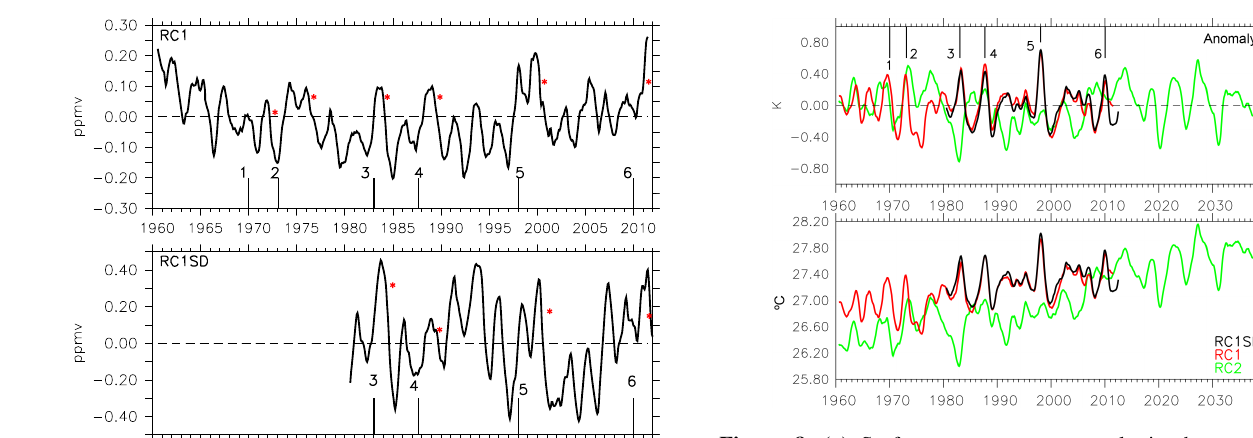
Figure 8. (a) Surface temperature anomaly in the tropical re- gion (10 ◦ S–10 ◦ N) (detrended, deseasonalized, 12-point running mean) for RC1SD (black), RC1 (red), and RC2 (green). Strong El Niño/La-Niña events are labelled. (b) Surface temperature (degrees Celsius) for RC1SD, RC1 and RC2 (12-point running